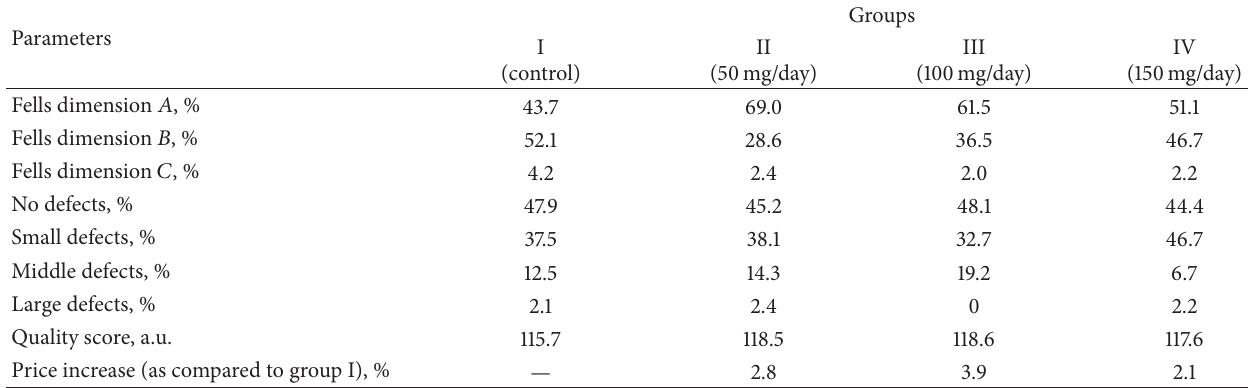
Table 5: Some parameters of the minks, essential for commercial